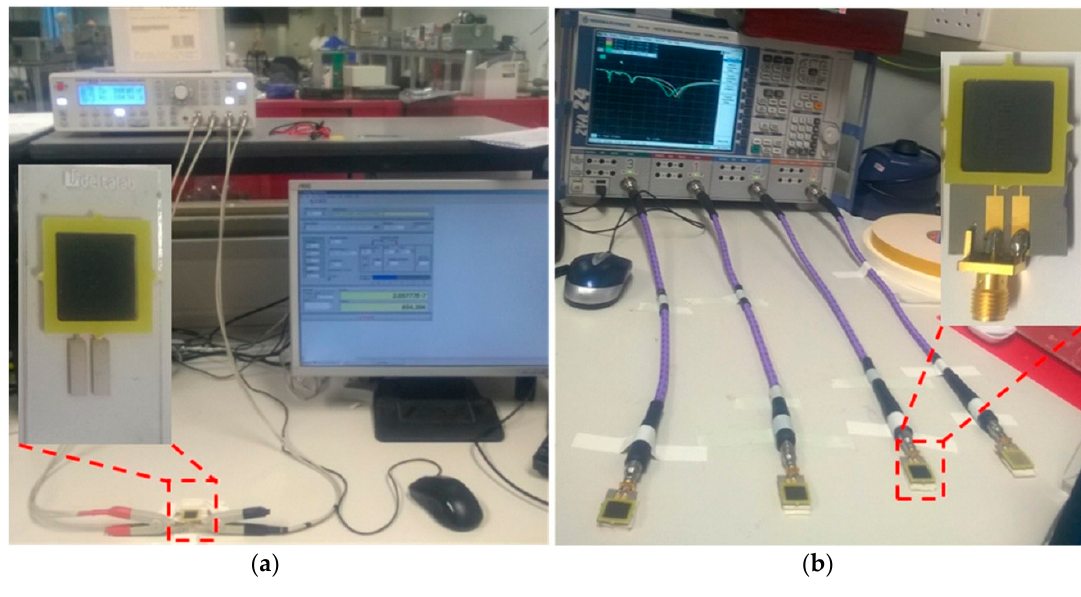
Figure 2. Experimental set-up: ( a ) LCR programmable bridge connected to an Ag-IDE screen-printed on microscope slide connected through crocodile clips; ( b ) VNA connected with coaxial cables to uncoated and f-EM sensors (Au-8 pair IDEs) with L-Cy-Ch-Ru based thick films